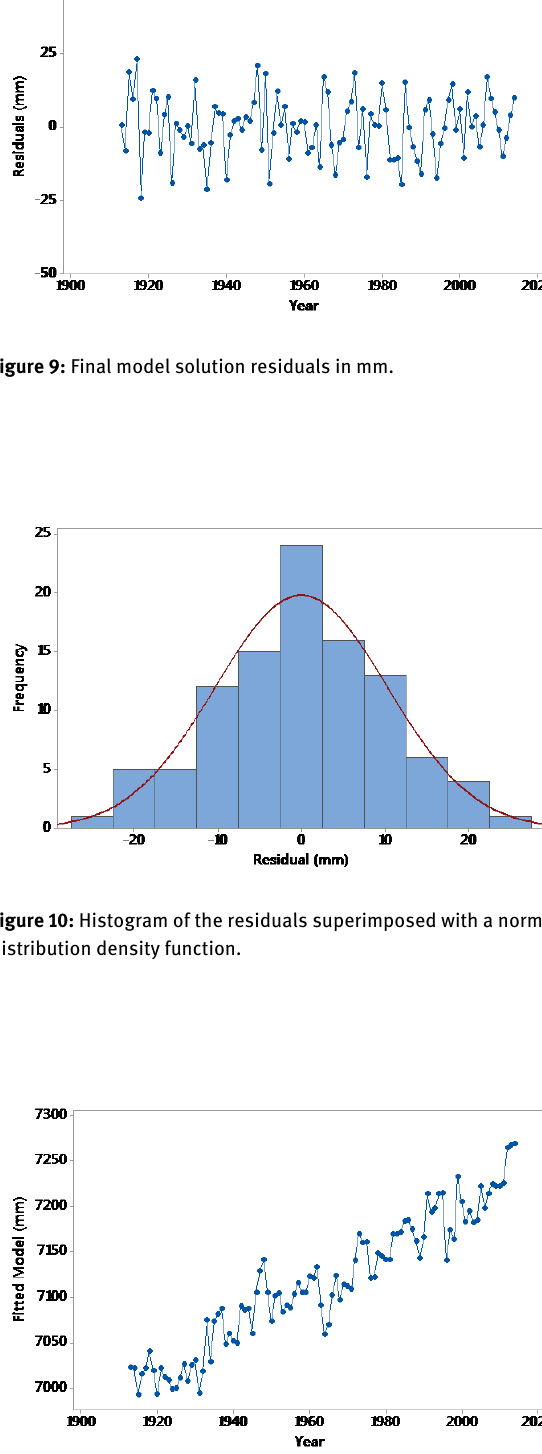
Table 3: Estimated model parameters. Trend in mm/yr, the coefl- cients of the periodicities and their errors are in mm, and the lag weights are in mm/ ∘ C. VIF: Variance Inflation Factor. ^ σ 0 = 12.8, Adj R 2 = 96.9%, Durbin-Watson Statistic = 2.05